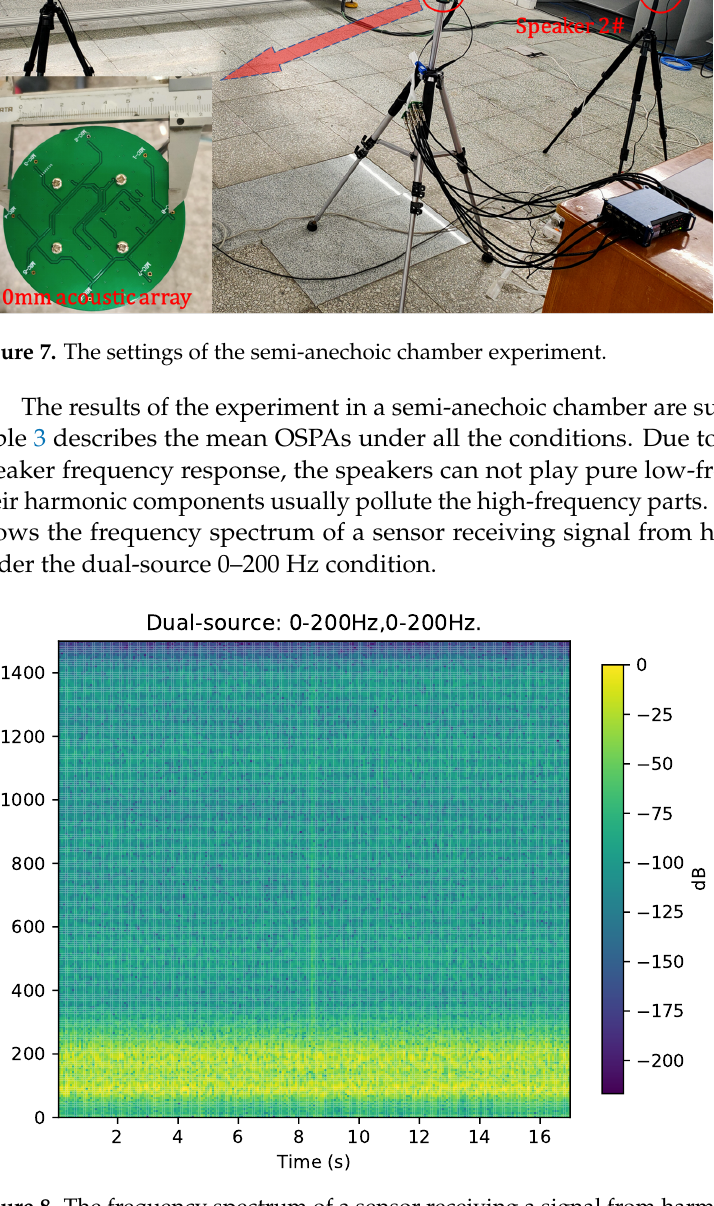
Figure 8. The frequency spectrum of a sensor receiving signal from harmonic interference under the dual-source 0-200Hz condition. the dual-source 0–200 Hz